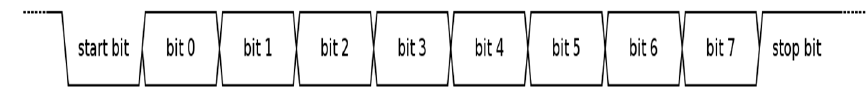
Figure 2. Example universal asynchronous receiver-transmitter (UART) data format.